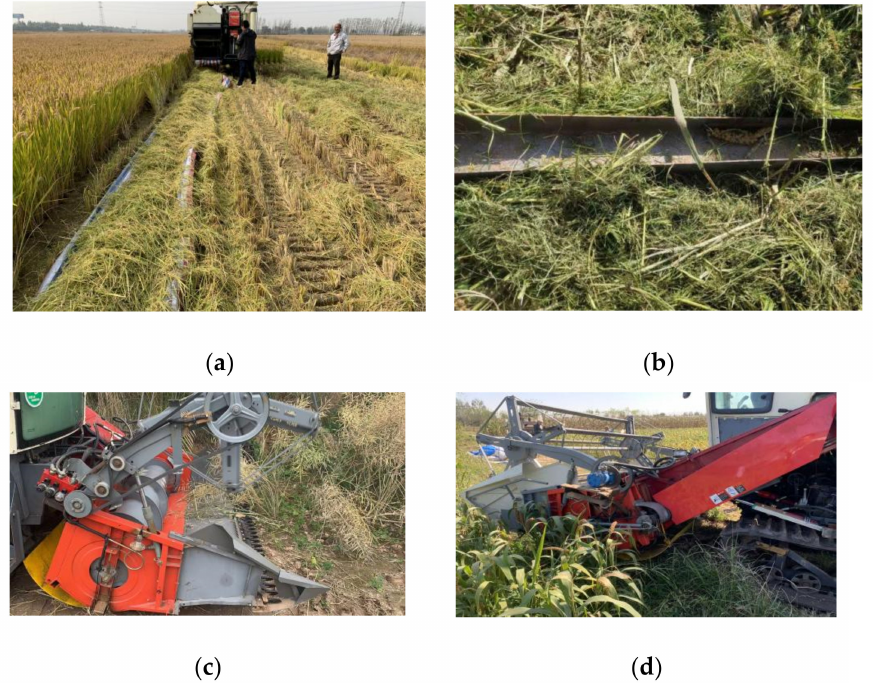
Figure 16. Test diagram. ( a ) Rice experiment; ( b ) Sampling slot method; ( c ) Rape experiment; ( d ) Millet experiment.